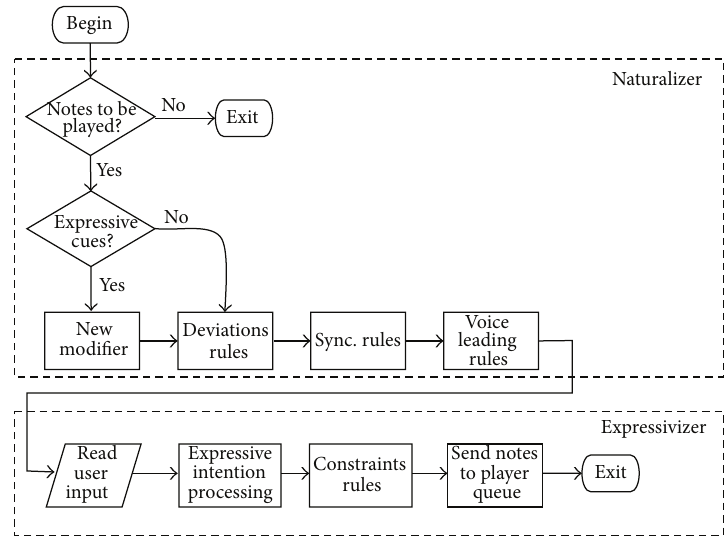
Figure 4: Schema of the PlayExpressive() function.